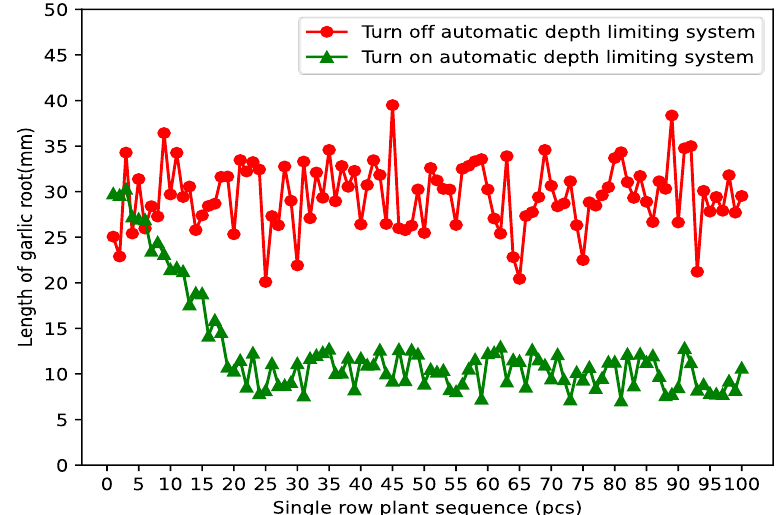
Figure 21. Garlic root length curves of garlic harvested with an automatic depth limiting system turned off and on.